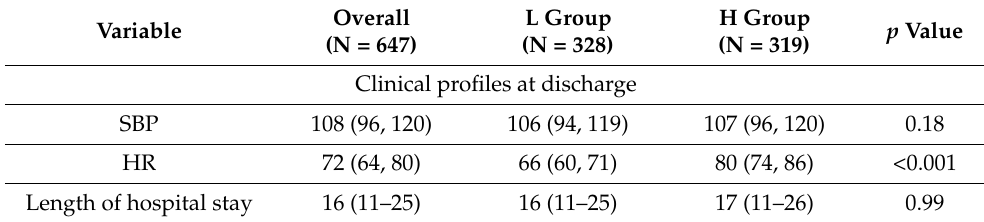
Table 2. Characteristics of the study population at